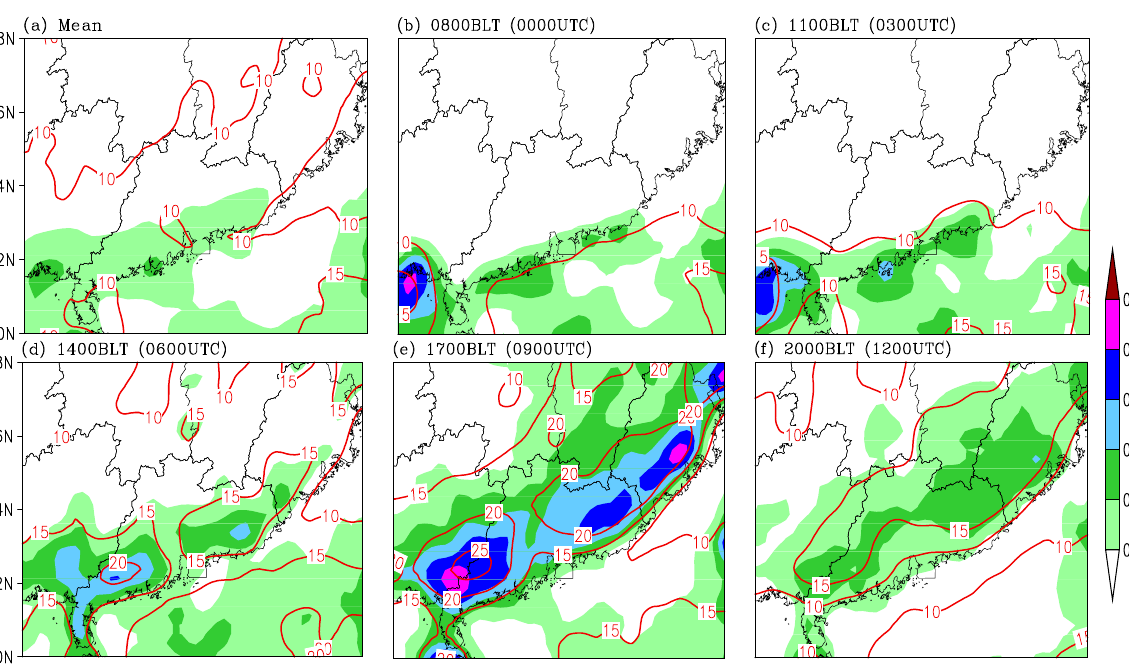
Figure 15. Mean hourly rainfall (shaded, unit: mm) and rainfall occurrence frequency (contours, unit: %) ( a ) and the diurnal evolution of rainfall intensity (shadings, unit: mm·h –1 ) and rainfall occurrence frequency (contours, unit: %) for the 2000-2009 climatology from July to September based on TRMM estimates at time of ( b ) 0800 BLT, ( c ) 1100 BLT, ( d ) 1400 BLT, ( e ) 1700 BLT, ( f ) 2000 BLT, ( g ) 2300 BLT, ( h ) 0200 BLT and ( i ) 0500